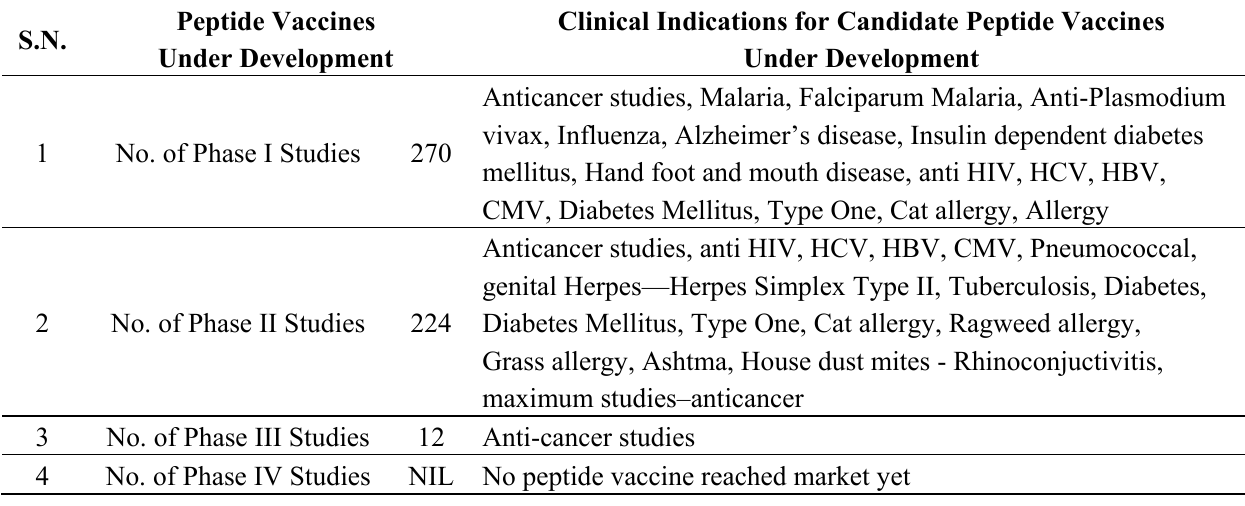
Table 1. Worldwide clinical trials of peptide